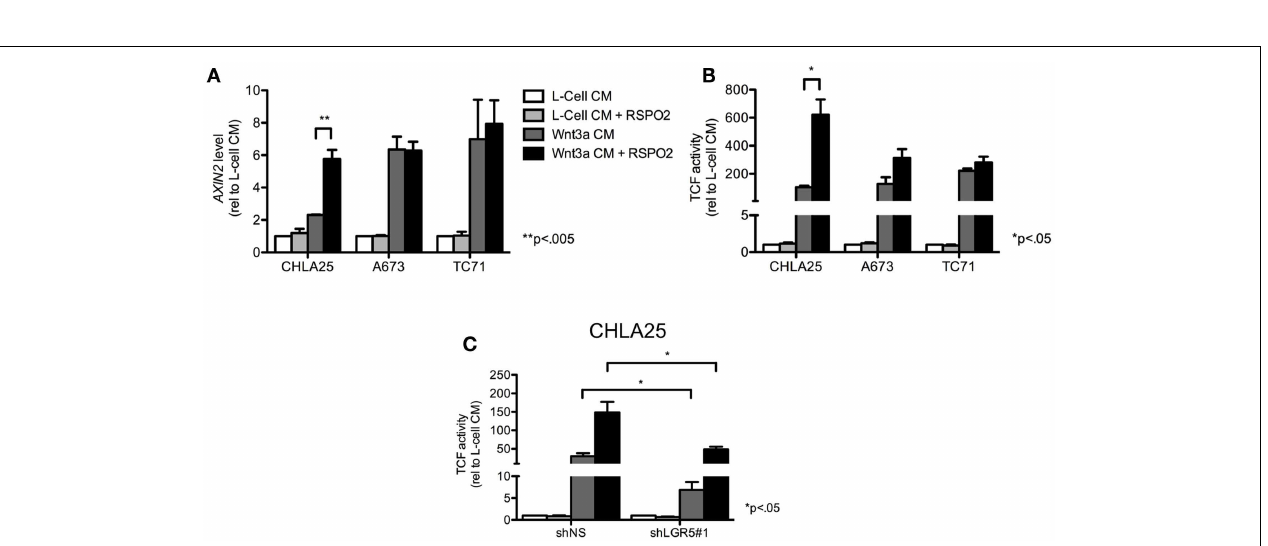
FIGURE 5 | ExogenousWnt3a induces nuclear localization of β -catenin and is potentiated by RSPO2. (A) CHLA25 cells grown in the presence of Wnt3a conditioned medium (CM) induced nuclear localization of β -catenin and this was robustly potentiated by the addition of RSPO2. RSPO2 alone had no